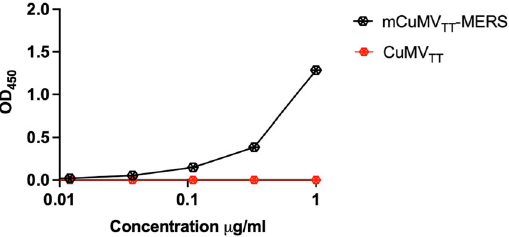
Fig. 2 RBM displayed on the surface of mCuMV TT -MERS vaccine binds human receptor DPP4. DPP4 binding of mCuMV TT -MERS vaccine candidate and CuMV TT as a control. Plates coated with 1 μ g/ml of DPP4. Binding revealed with an anti-CuMV mAb. One representative of three similar experiments is